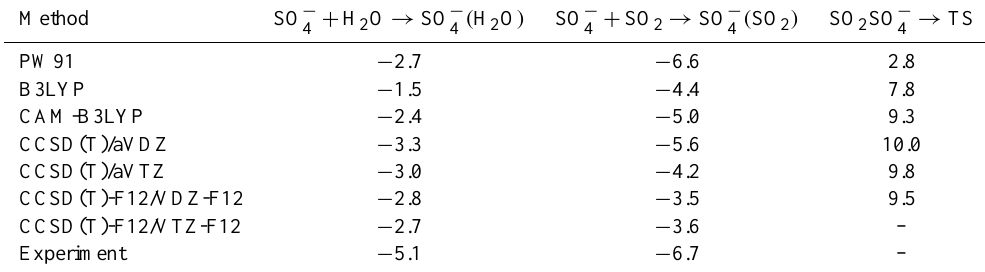
Table 1. Comparison of Gibbs free energy changes of the indicated reactions calculated by different DFT functionals, all using the aug-cc- pVDZ (aVDZ) basis set. Electronic energy corrections are performed using the indicated coupled cluster methods and basis sets and the corrected Gibbs free energies are calculated according to Eq. (1). Experimental data from Fehsenfeld and Ferguson (1974) are included. Energy units are kcalmol − 1